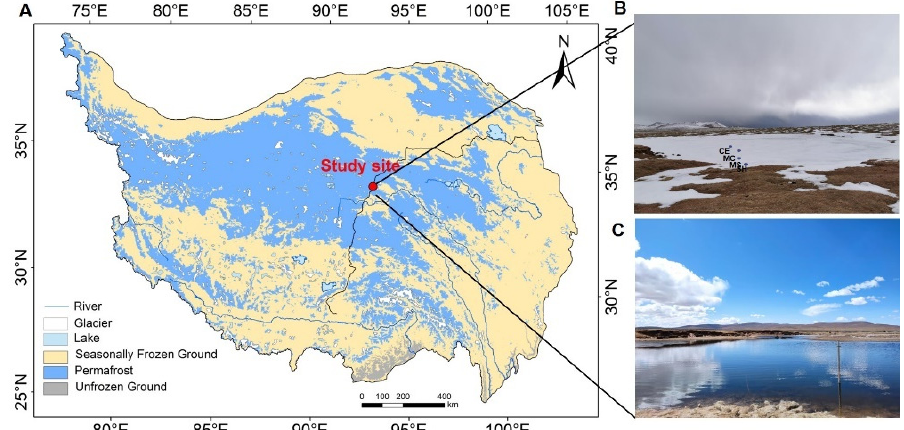
Figure 1. ( A ) Location of the study site in the continuous permafrost of the TP. The frozen-ground map of the TP was plotted with referring to the study of Zou [48]. ( B ) Four sampling points: shallow points (MS, SH), deep points (MC, CE). ( C ) The thermokarst lake in spring.